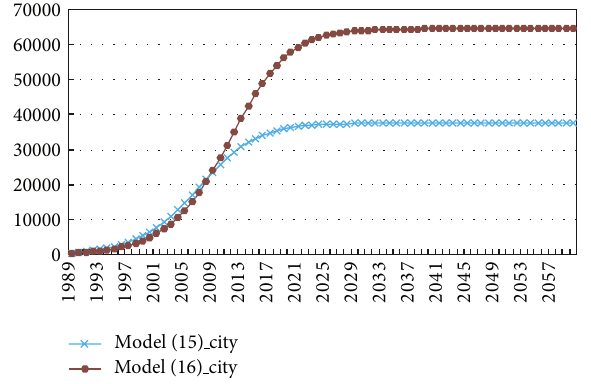
Figure 14: Plots of potential curve of telephone in urban area governed by model (69) or model (70).